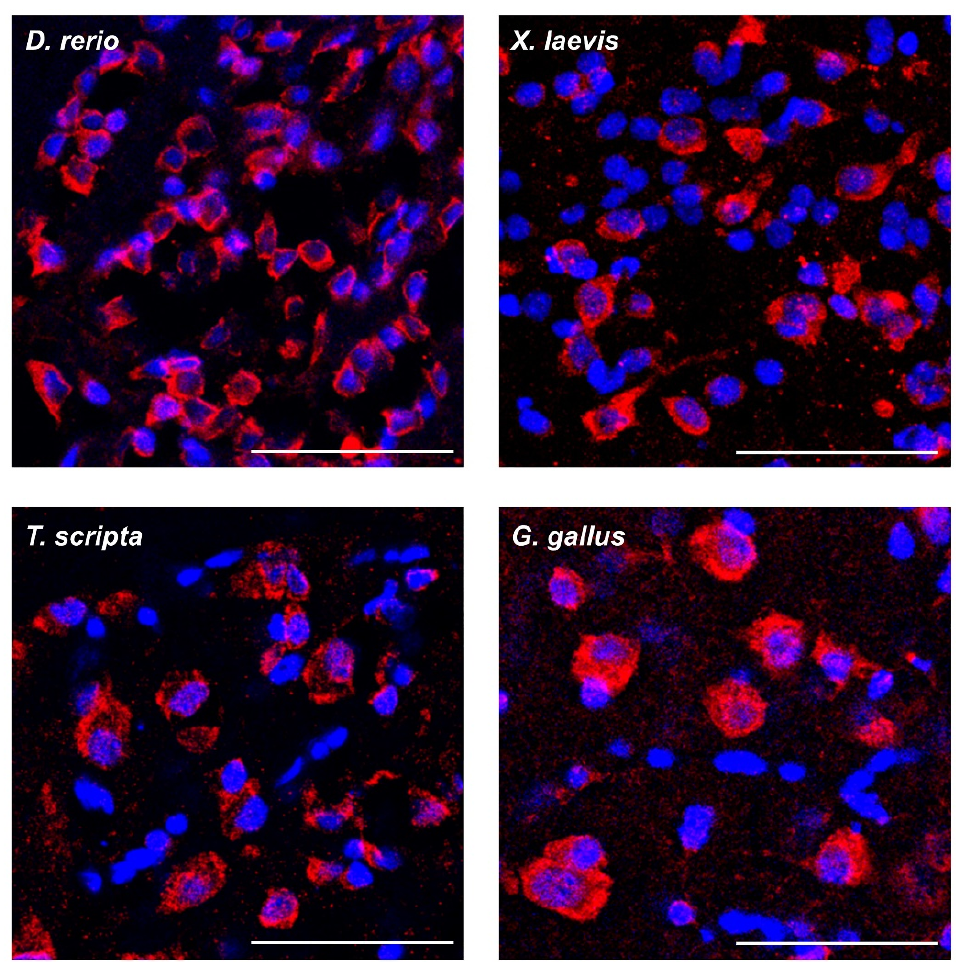
Figure 5. Anti-amyloid OC antibodies (red signal) recognize cytoplasmic structures in brain neurons of all studied vertebrate species. Blue signal corresponds to the nuclear dye DAPI; scale bar is 50 µm.